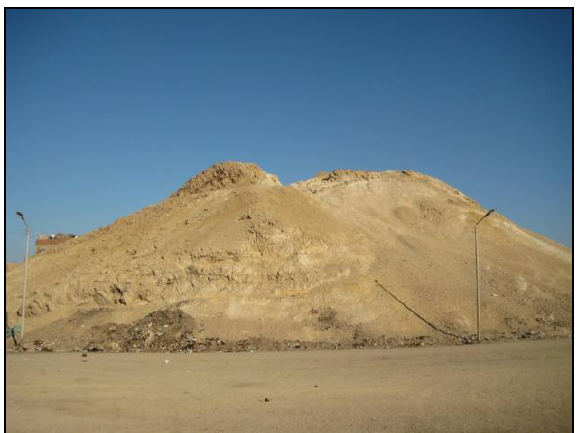
Figure 1b: Location map for Au-Roash area.